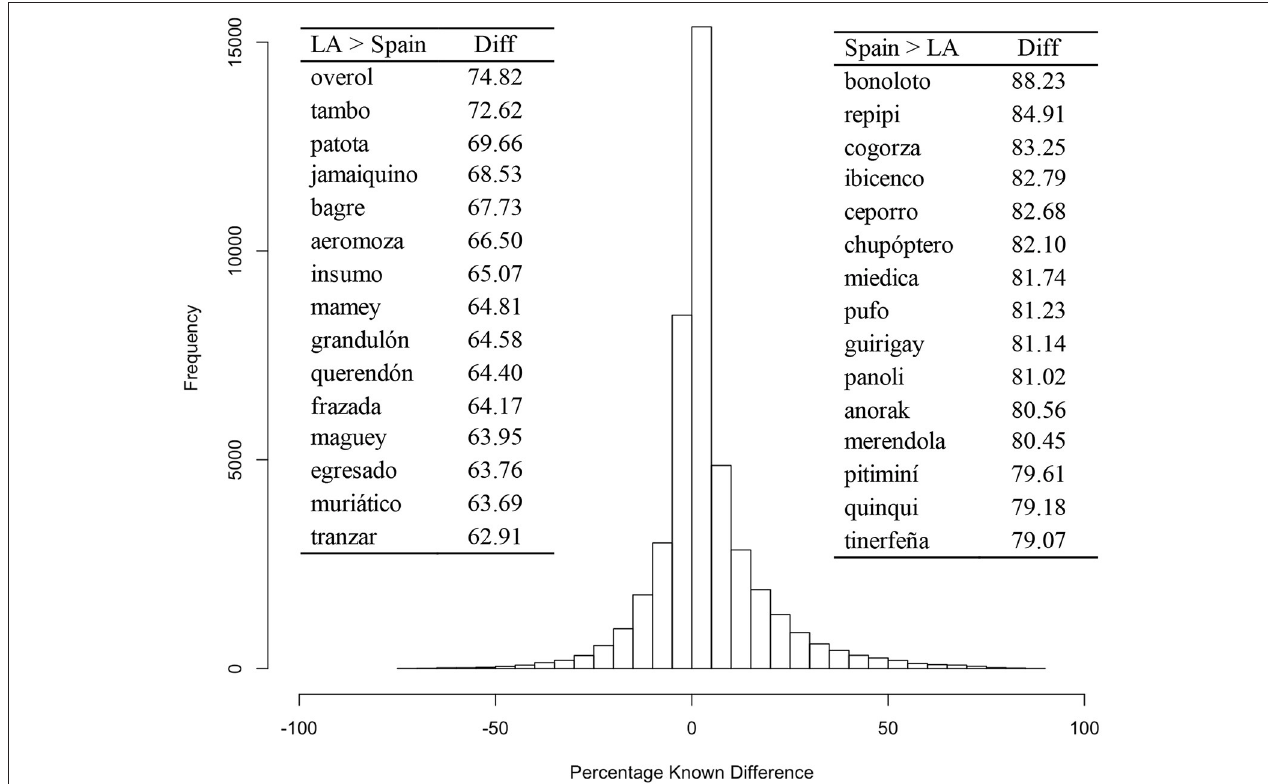
FIGURE 2 | Histogram of the percentage known difference of each word between Spanish and Latin-American natives. The fifteen words with the highest differences for each group are also shown to the right and left of the histogram. LA, Latin-America; Diff, Absolute percentage known